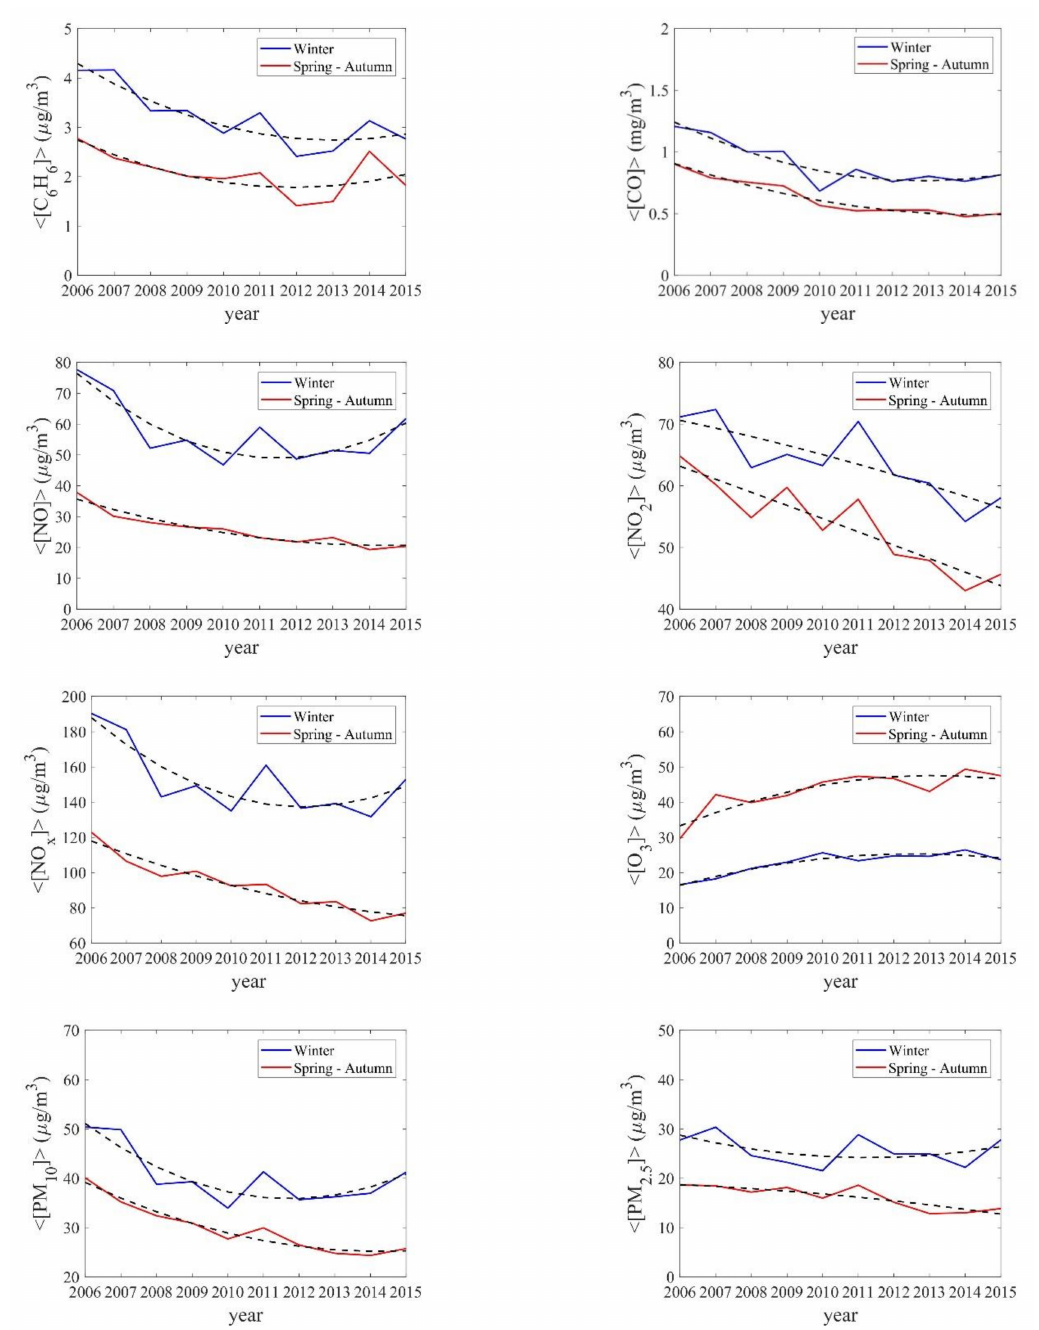
Figure 2. Average pollutant concentrations trend of Rome over the decade 2006–2015 of winter (blue line) and spring-autumn (red line). Dashed lines are referred to as trend